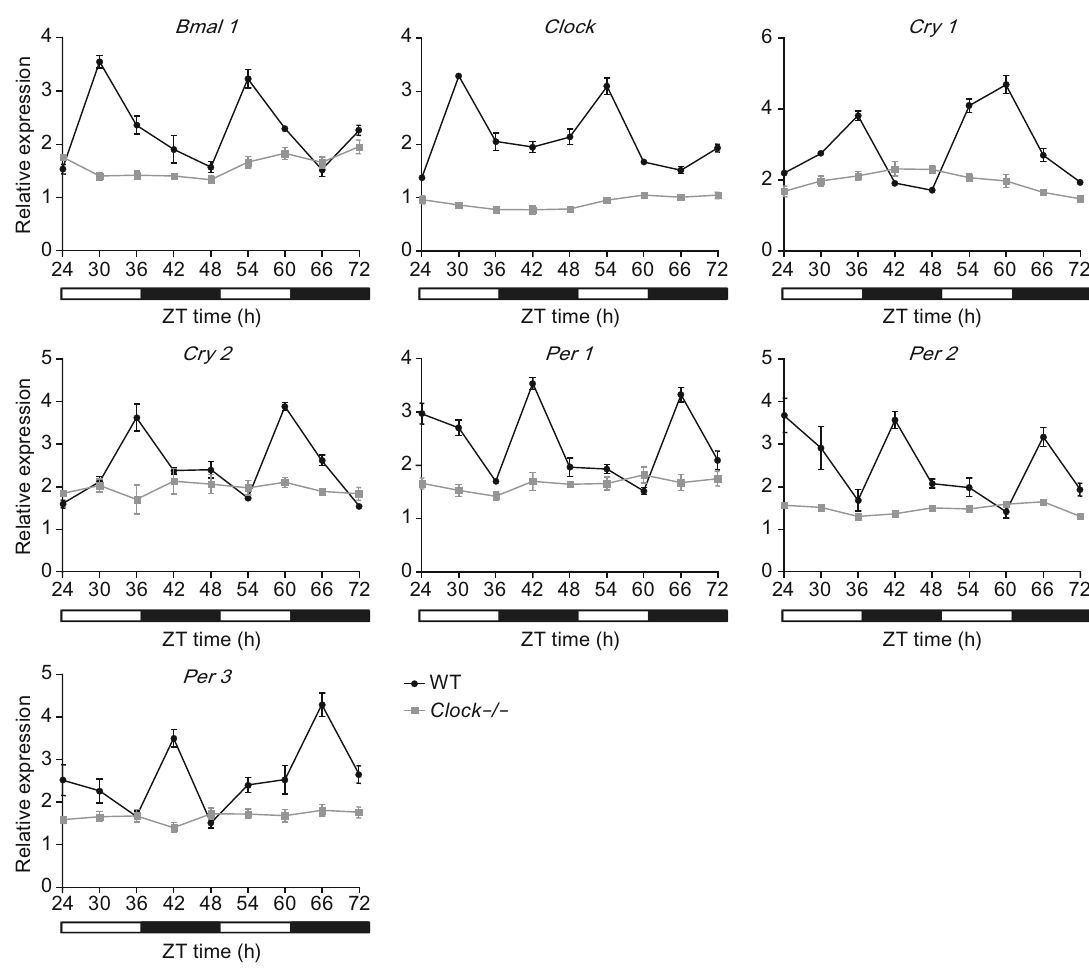
Figure 6. Clock silencing disturbed the circadian oscillations during mESC differentiation. Relative mRNA expression of core clock genes Bmal1, Clock, Cry1, Cry2, Per1, Per2 , and Per3 in spontaneously differentiated wild type and Clock -/- mESCs after serum shock induced biological rhythms. ZT0 to 72 represent 8:00 am to 8:00 am of day 4, respectively. The mRNA expression levels were normalized to that of the endogenous GAPDH . Compared with wild type mESCs, Clock -/- mESCs showed no circadian oscillation in the expression of core clock genes. Data represent the average of three independent experiments and are presented as means